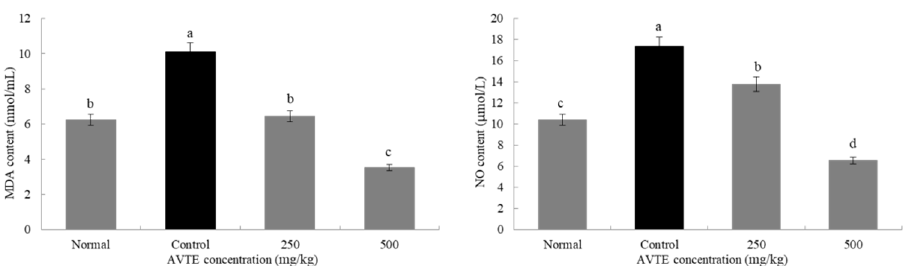
Figure 2. Effects of AVTE on malondialdehyde (MDA) and nitric oxide (NO) in serum of the mice. a–d Mean values with different letters in the same bar graph are significantly different ( p < 0.05) according to Duncan’s multiple range test.